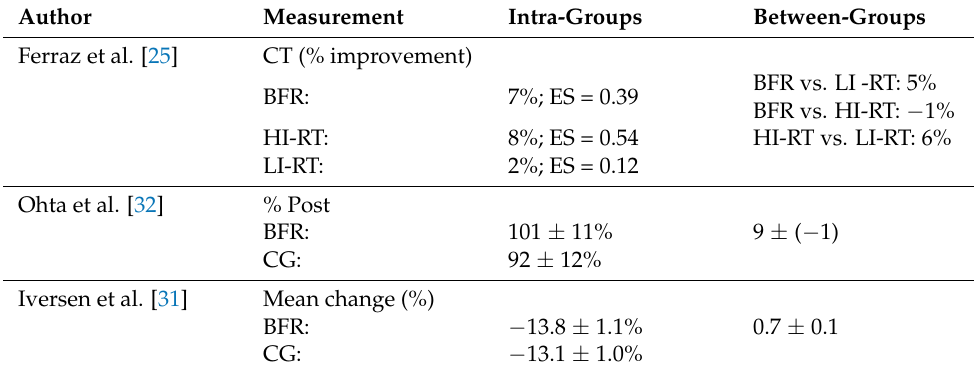
Table 3. Quadriceps CSA